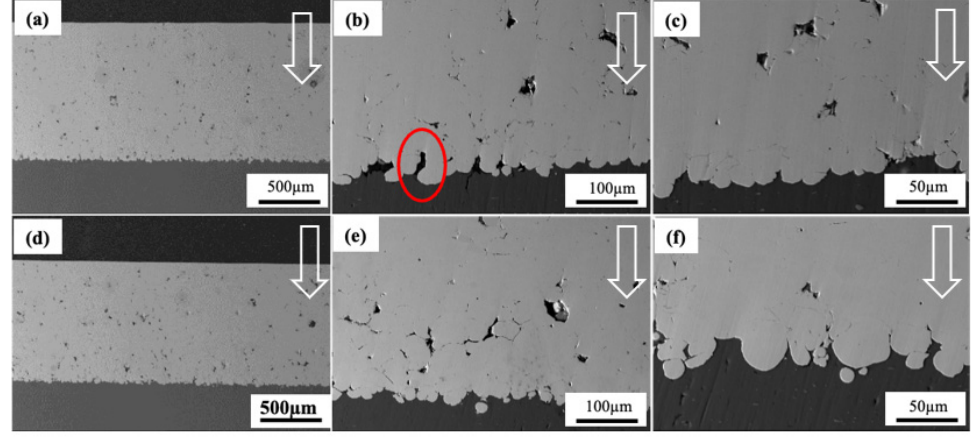
Figure 11. ( a – c ) BSE images for GA coating; ( d – f ) BSE images for CA316 coating.